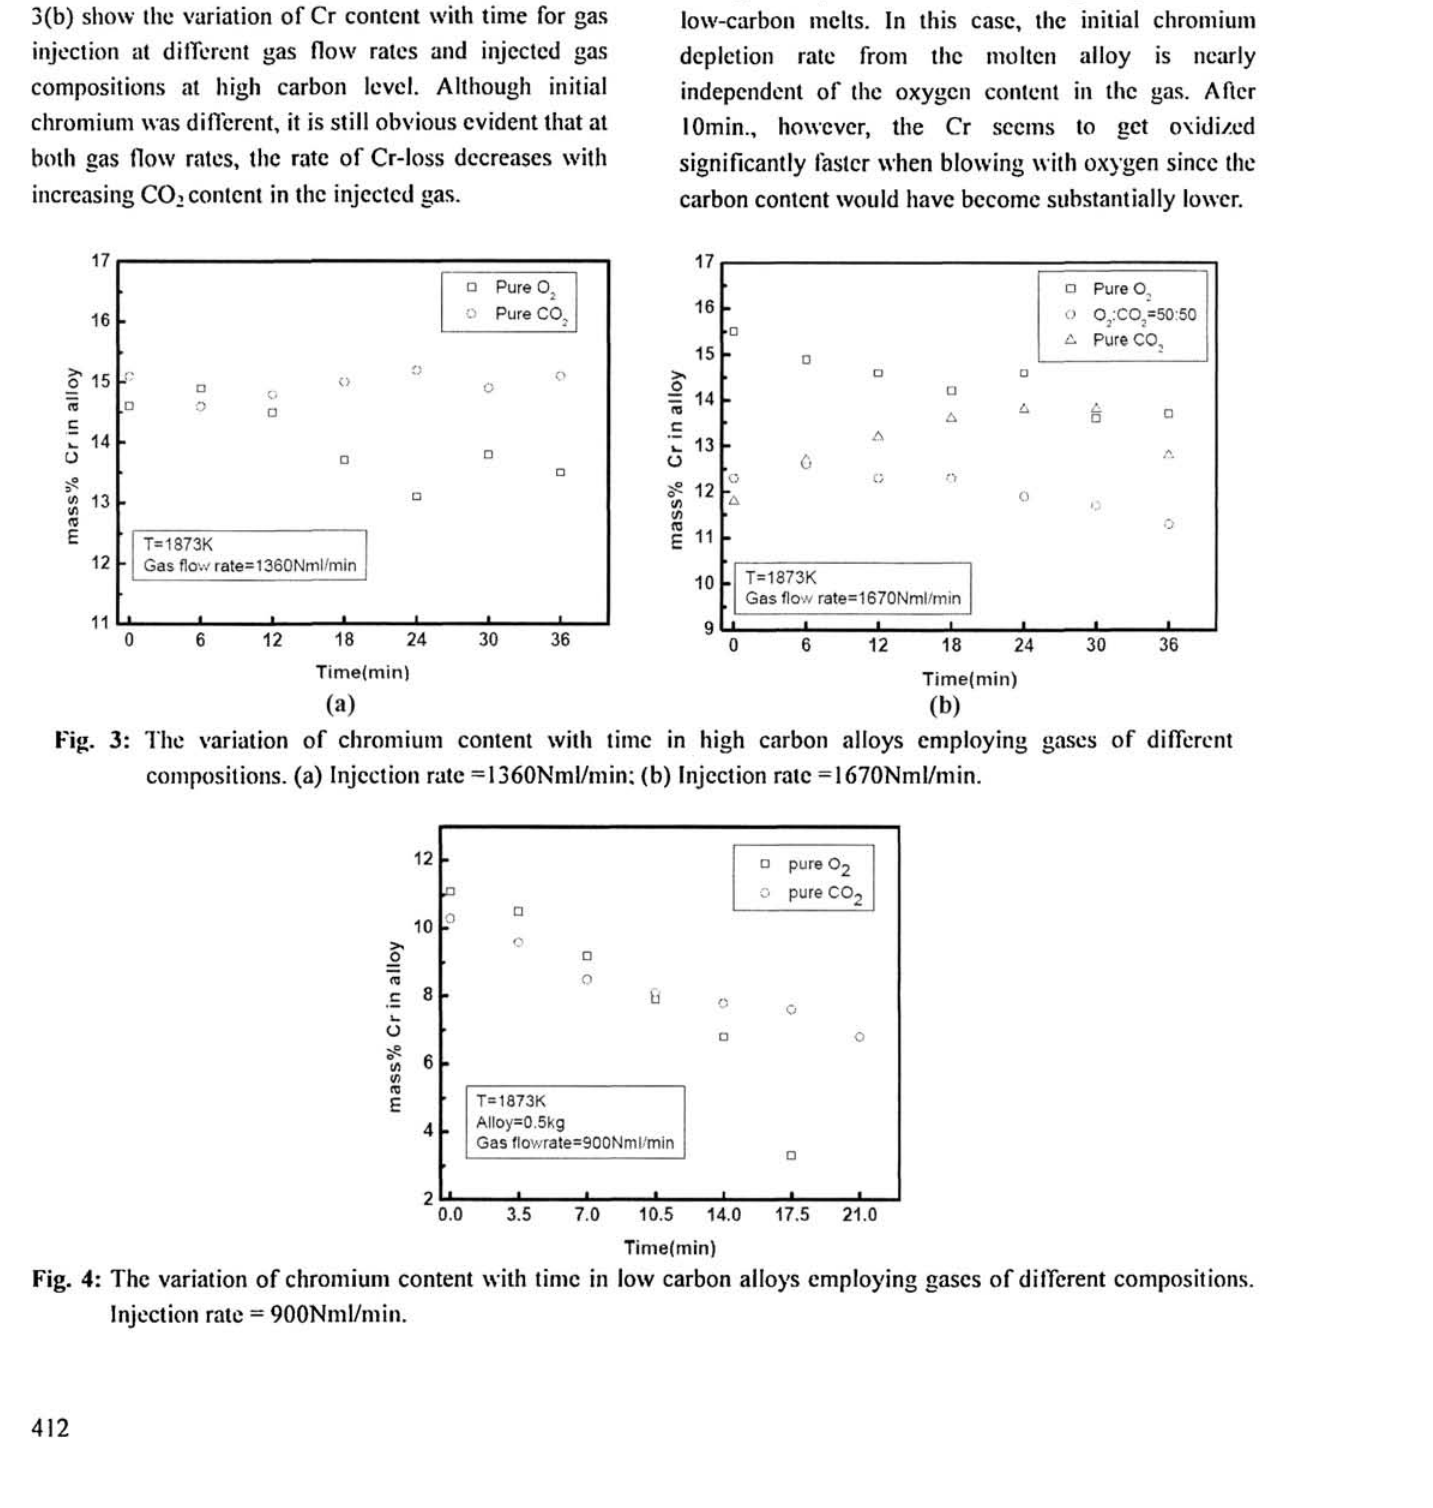
Fig. 4: The variation of chromium content with time in low carbon alloys employing gases of different compositions. Injection rate =